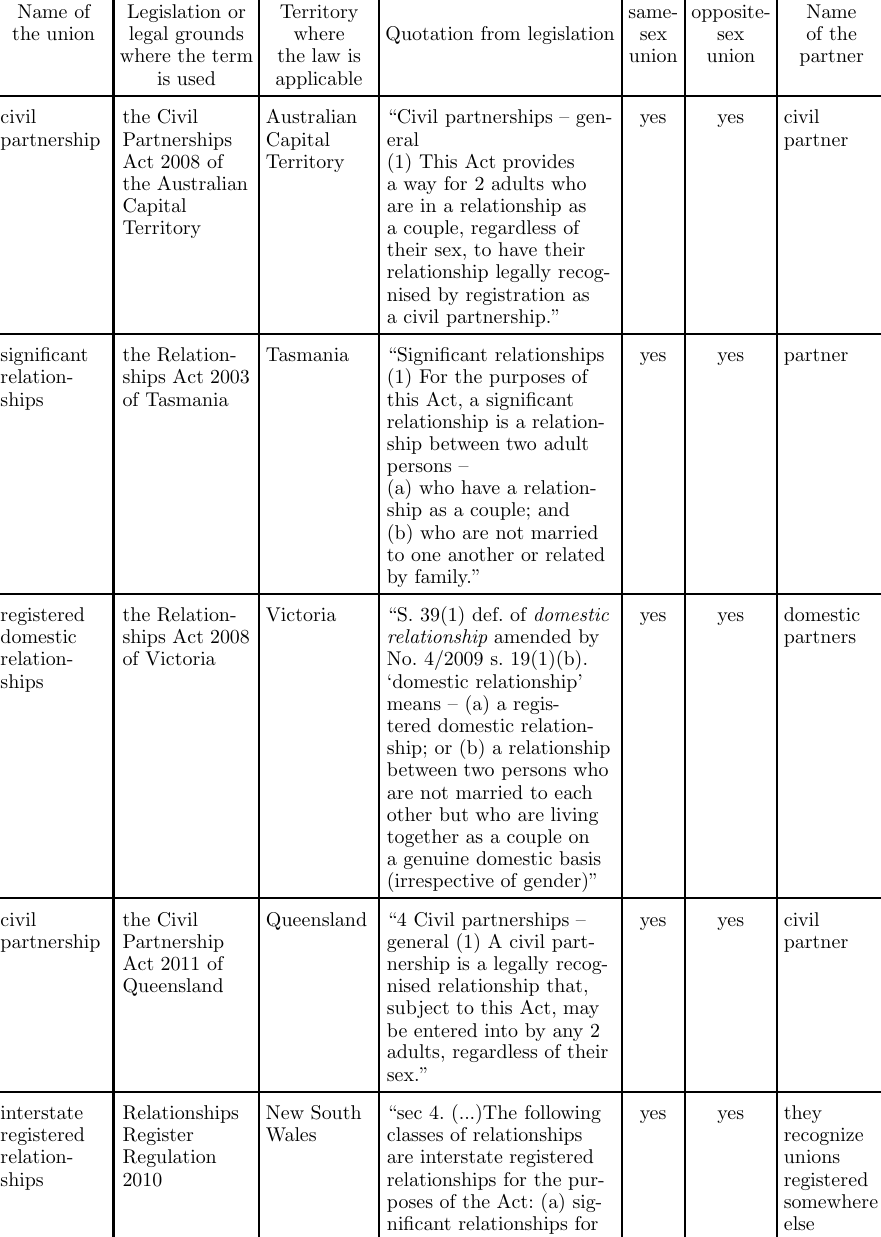
Table 2 Juxtaposition of terminology used in some jurisdictions registering same-sex marriages in